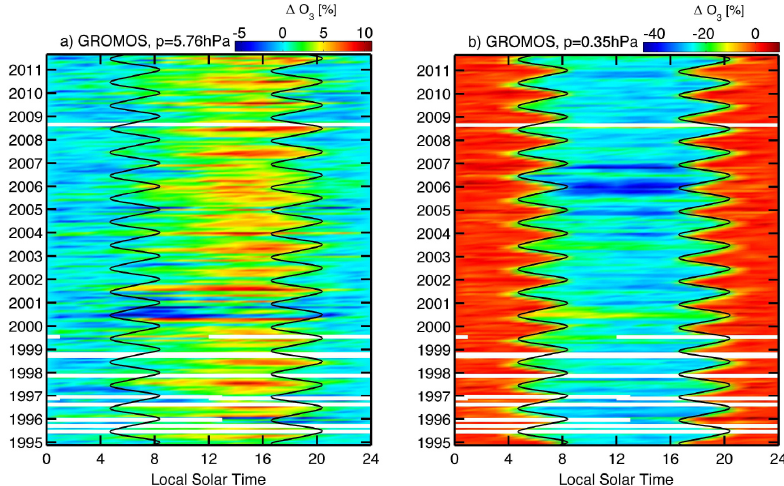
Figure 9. Interannual variability of the diurnal ozone variation from Nov 1994 to Oct 2011. (a) shows the interannual variability at 5.76hPa in the stratosphere. (b) depicts the interannual variability at 0.35hPa in the lower mesosphere.